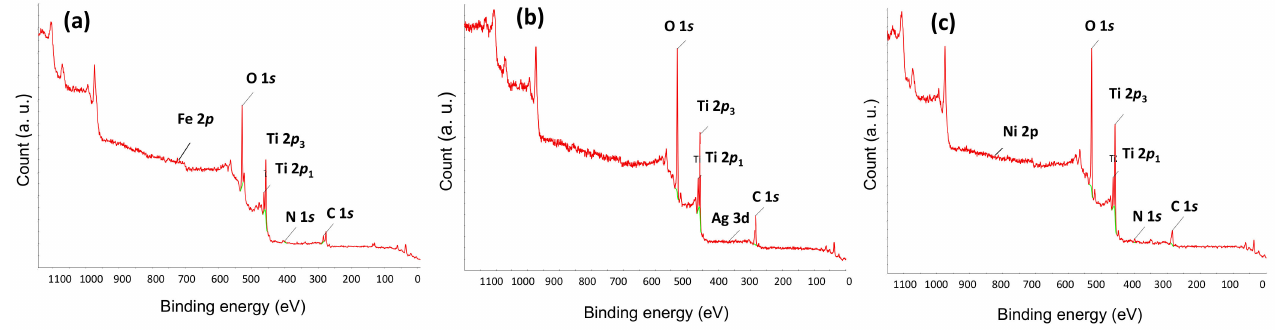
Figure 5. XPS spectra of ( a ) NFT, ( b ) NAT, and ( c ) NNT.